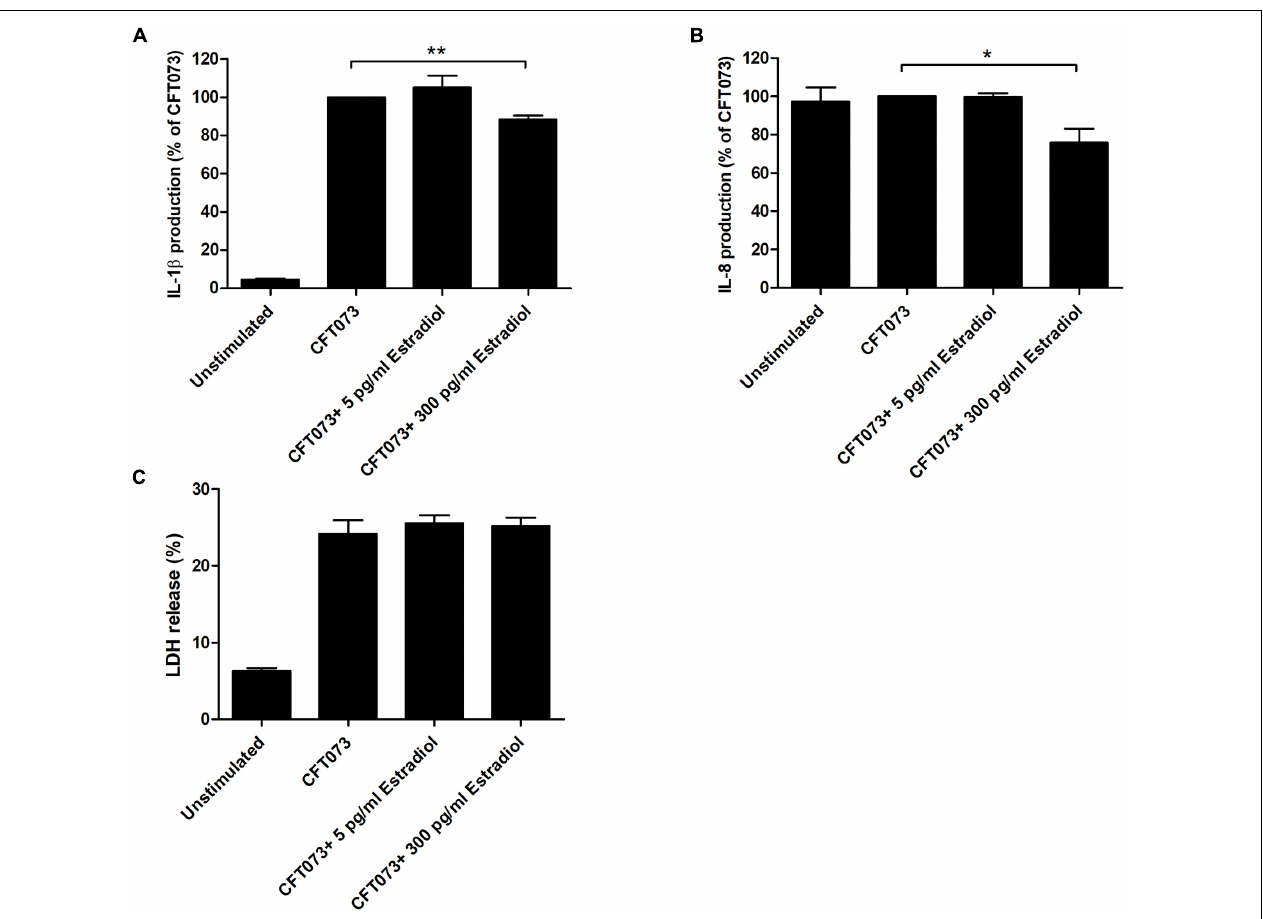
FIGURE 7 | IL-1 β (A) , IL-8 (B) , and LDH (C) release from bladder epithelial cells infected with CFT073 pretreated with or without estradiol (5 and 300 pg/ml) at 6 h. Data are presented as mean ± SEM of n = 4 independent experiments. The asterisks distinguish statistical significance: * p < 0.05 and ** p < 0.01 vs. unstimulated